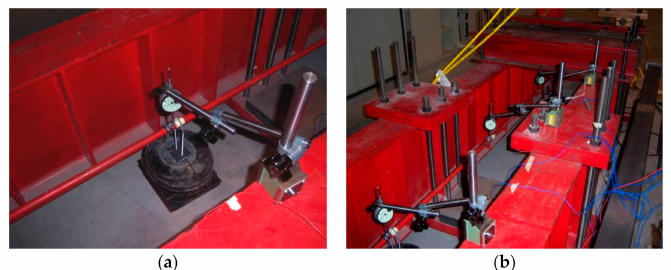
Figure 1. Static NDT methods proposed by Tullini et al. [71,74]: ( a ) cast iron disks suspended at the reference beam; ( b ) arrangement of the dial indicators for vertical deflection measurements during an experimental simulation. Copyright © 2012, 2013 Elsevier Ltd. Reprinted with permission.